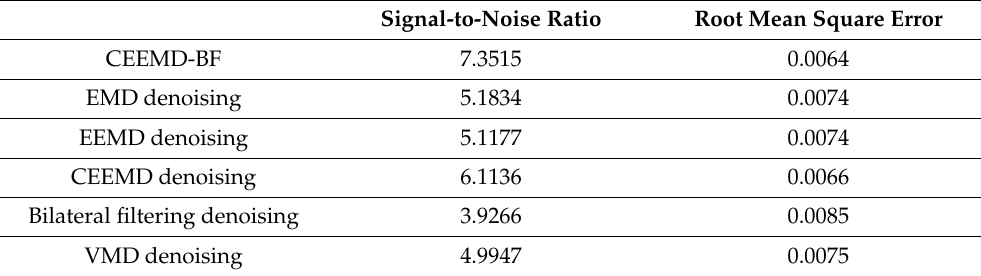
Table 1. Evaluation index of denoising.